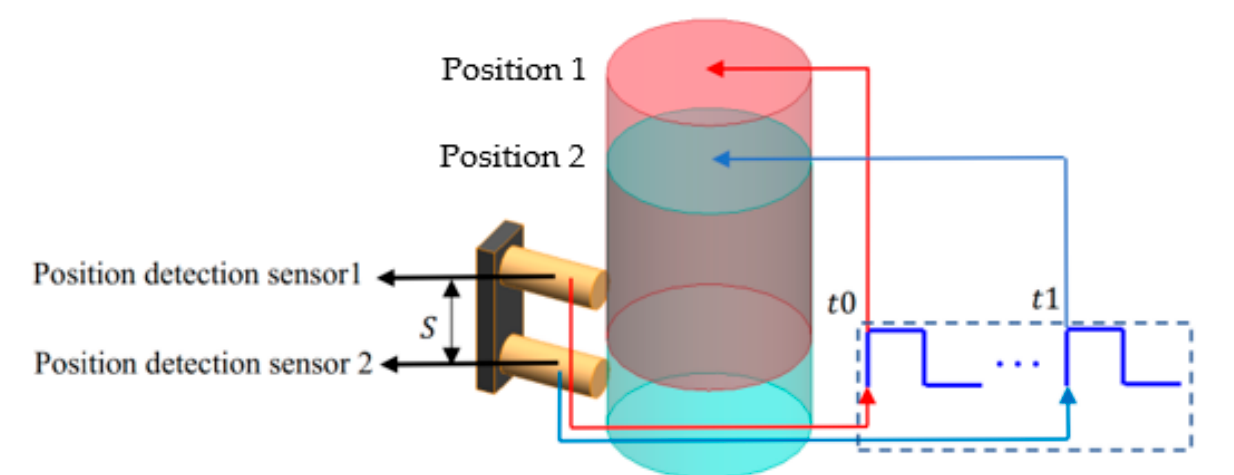
Figure 1. Impact velocity measurement principle based on position detection sensors.